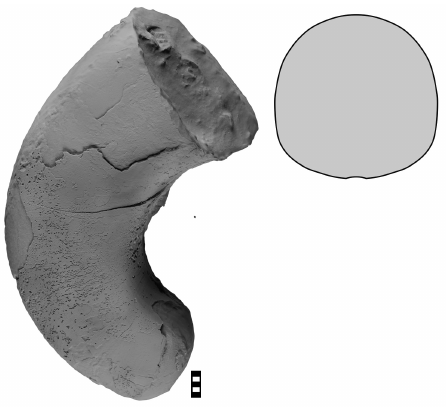
Fig. 30. Lispoceras sp. 1, specimen MB.C.30487 from Oued Temertasset (Korn et al . 2002 Coll.); lateral view and whorl profile. Scale bar units = 1